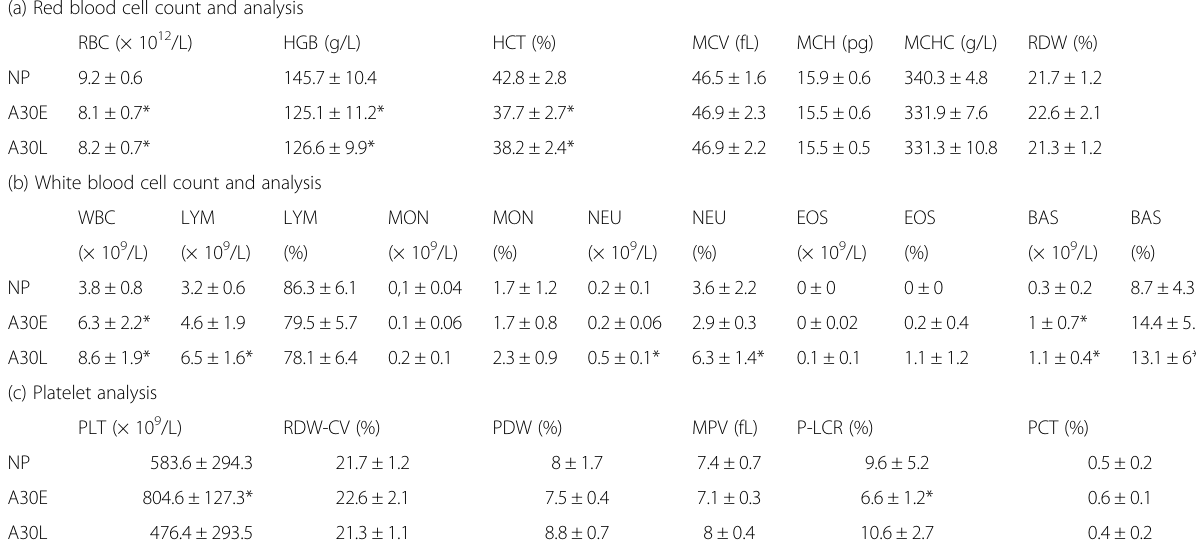
Table 3 Hematological assessment of pregnant mice (a) Red blood cell count and analysis